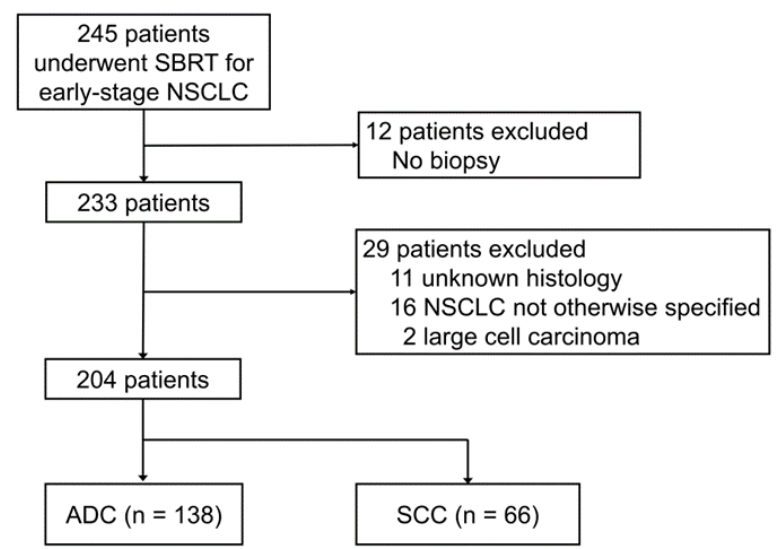
Figure 1. Algorithm for the study cohort.